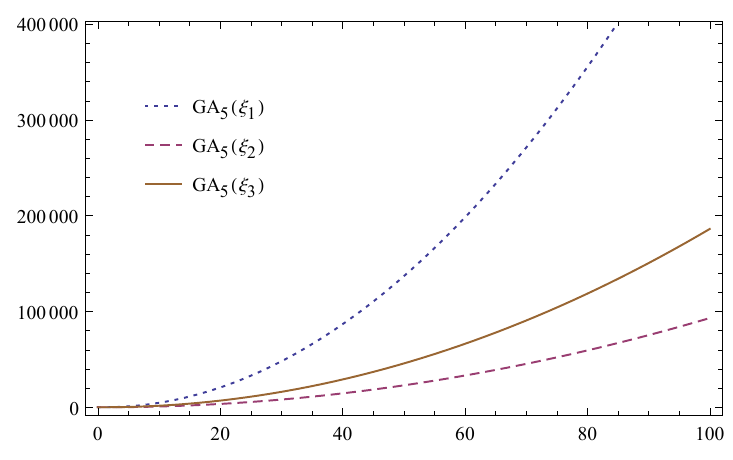
Figure 6. Comparison of GA 5 index for ξ 1 , ξ 2 and ξ 3